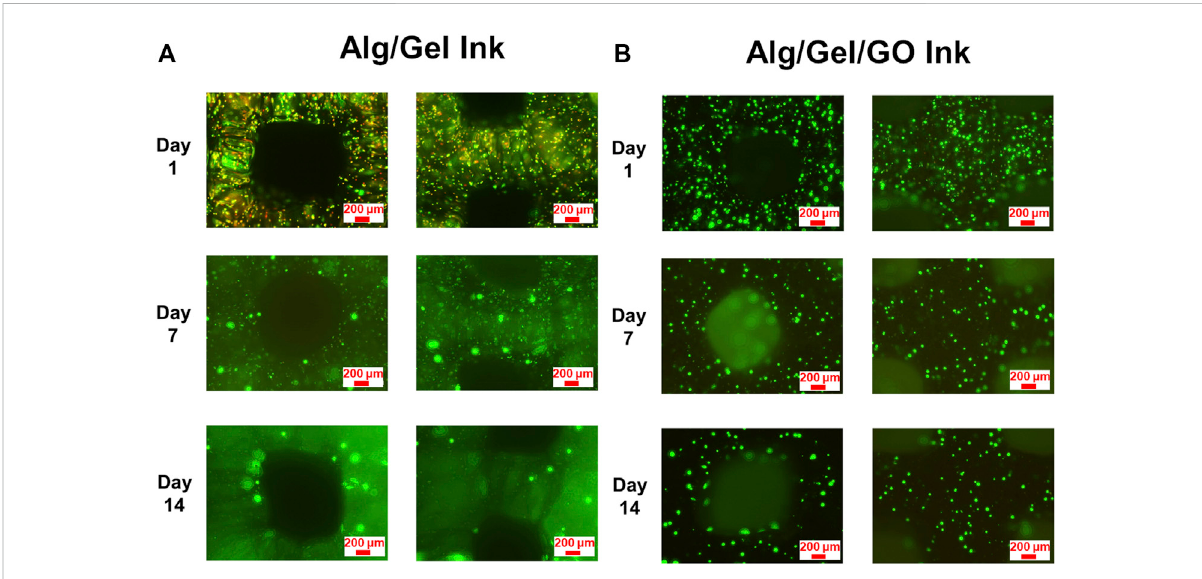
FIGURE 6 Viability and distribution of 3D printed ADSCs. Fluorescence images of live (Calcein AM; green) and dead (PI; red) cell staining for 3D printed ADSC-ladenscaffoldswithcompositionsof (A) 2%/3%(w/w)Alg/Geland (B) 2%/3%/0.05%(w/w)Alg/Gel/GOfollowing14 dayscultureafterprinting.